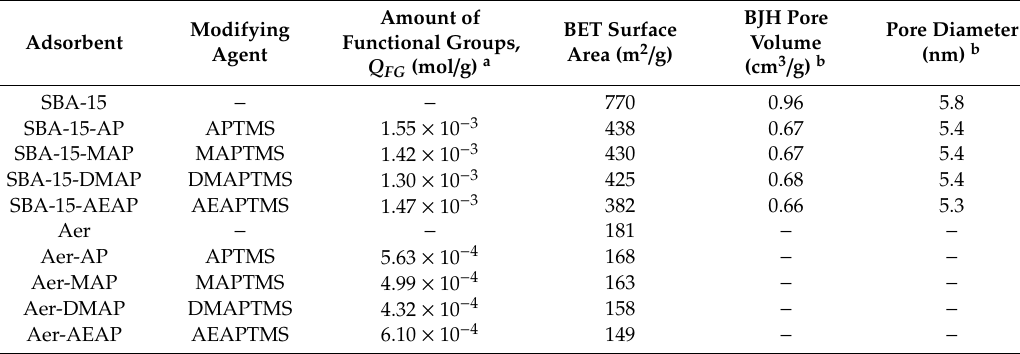
Figure 2. Nitrogen adsorption-desorption isotherms of ( a ) SBA-15, ( b ) SBA-15-AP, ( c ) SBA-15-MAP, ( d ) SBA-15-DMAP, and ( e ) SBA-15-AEAP mesoporous silicas. The isotherms were shifted from each other by 450 cm3 / g along the Y-axis. Table 2. Textural properties of siliceous